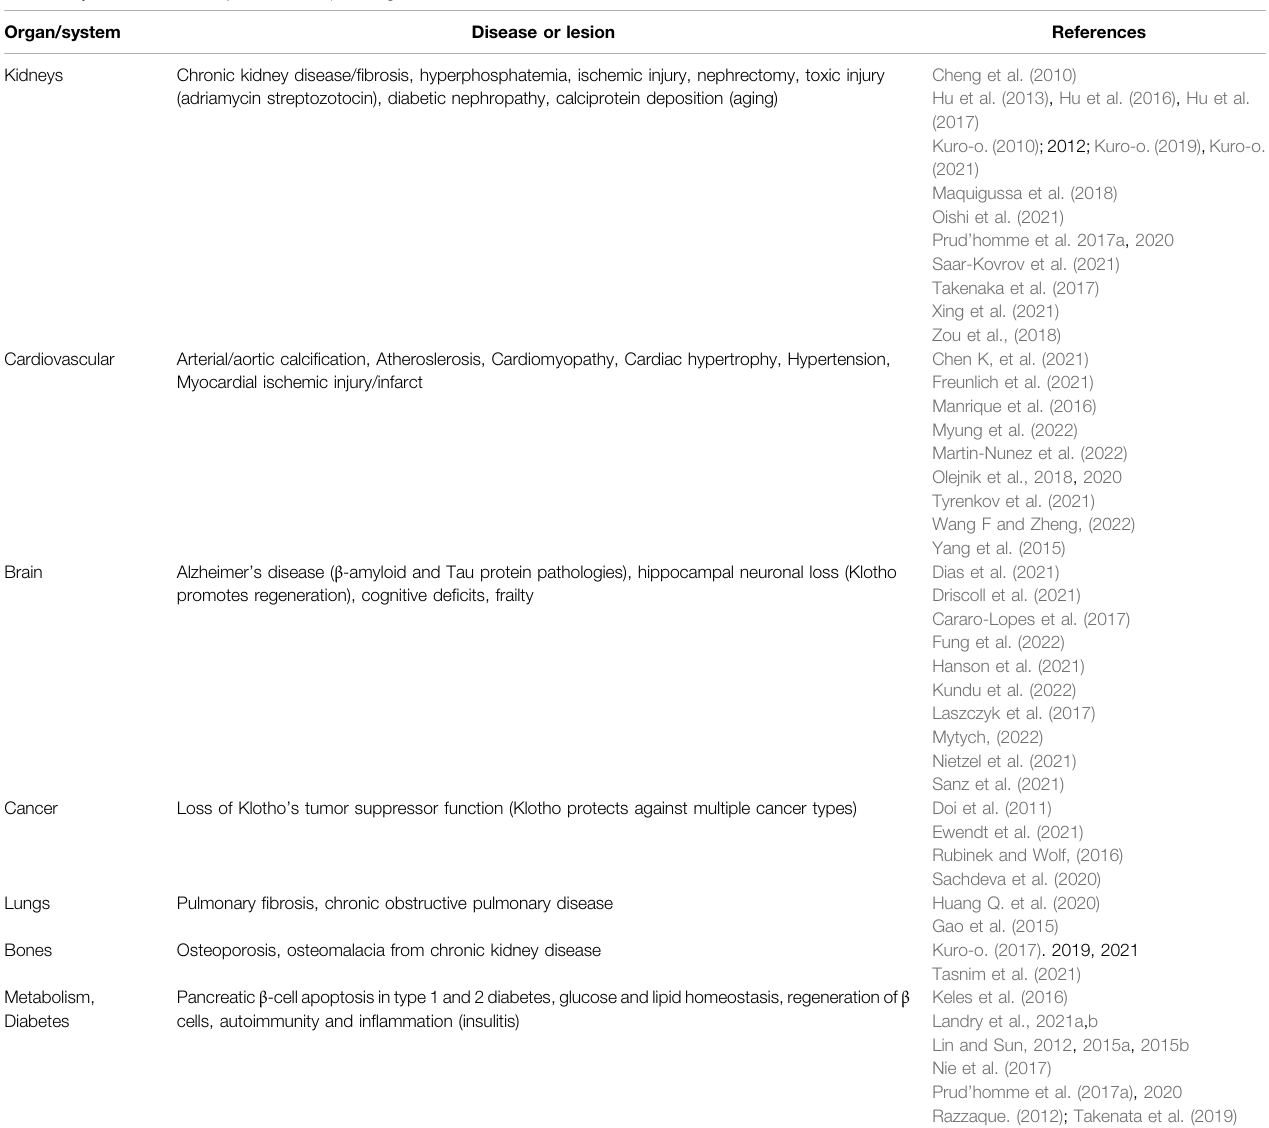
TABLE 1 | Klotho insuf fi ciency and related